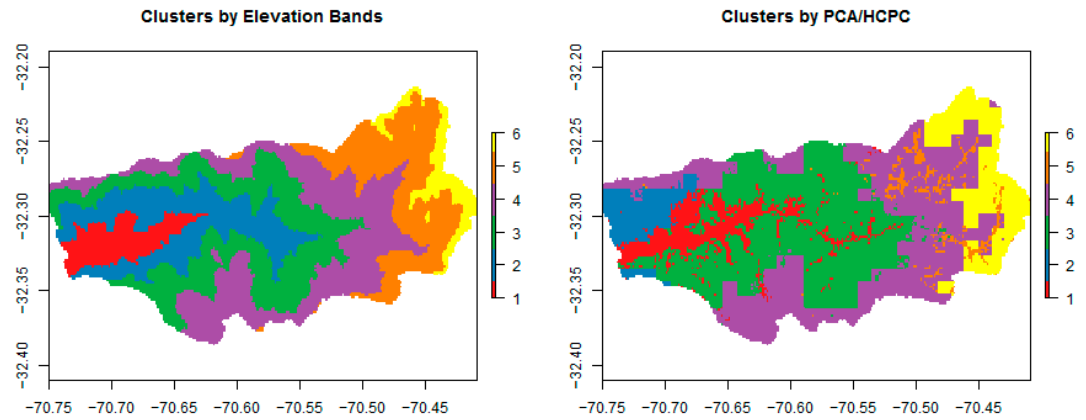
Figure 5. Elevations bands every 550 m ( left ), as used in the traditional methodology, and hydrological response unit (HRU) delimitations ( right ) for the simulation with six HRUs by the PCA/HCPC methodology.